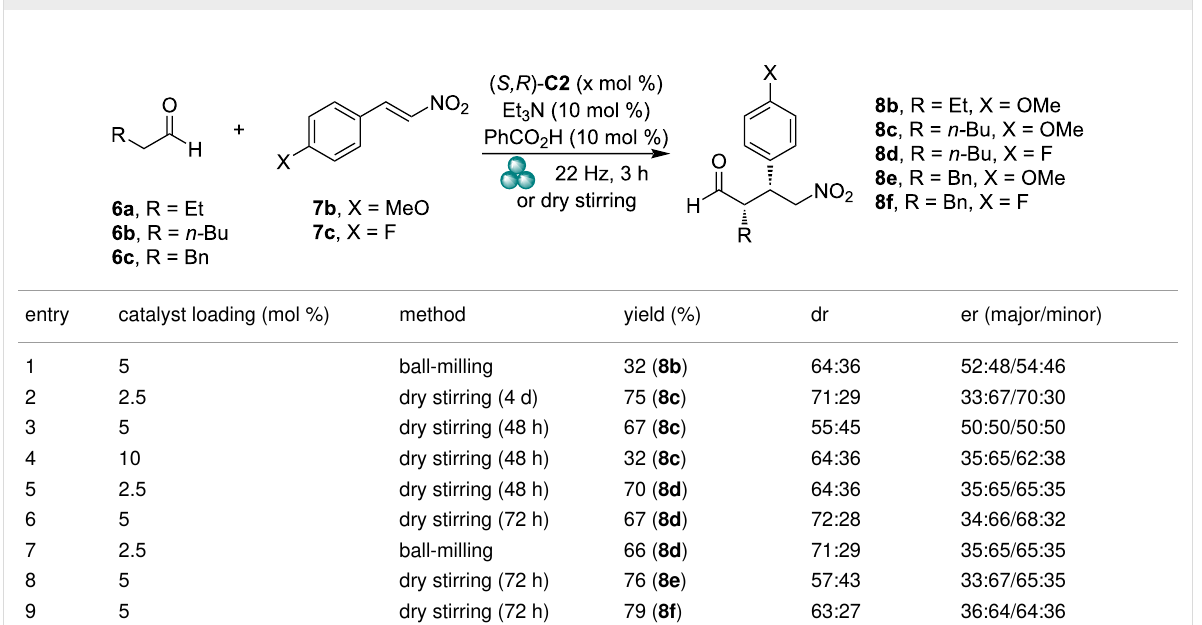
Table 4: Michael addition of aldehyde 6a – c to nitroalkenes 7a and 7b .